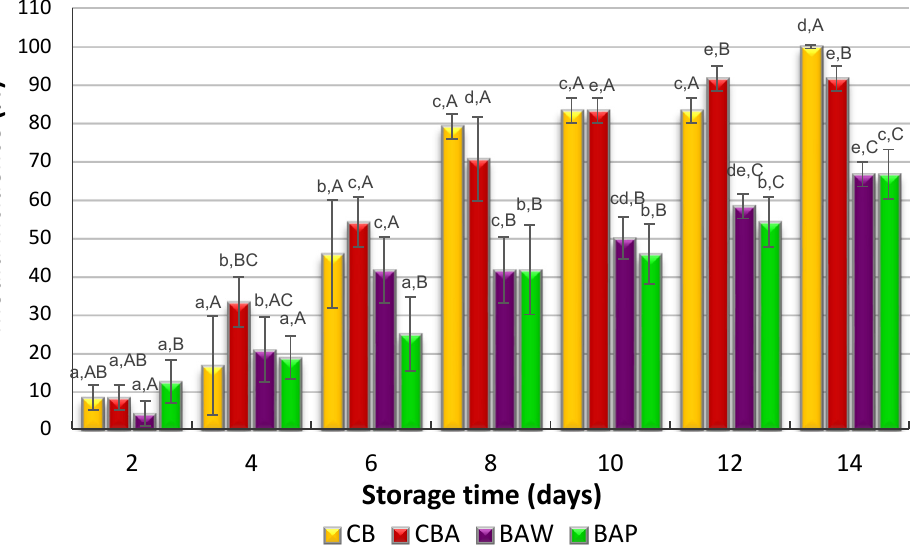
Figure 3. The effect of biofilms with W. anomalus or P. membranifaciens on the incidence of B. cinerea on apple fruit. CB: fruit injured and inoculated with B. cinerea ; CBA: fruit injured and inoculated with B. cinerea , coated with alginate; BAW: fruit injured and inoculated with B. cinerea , coated with alginate containing W. anomalus ; BAP: fruit injured and inoculated with B. cinerea , coated with alginate containing P. membranifaciens. a–e: values with different superscript Roman letters (for each storage time) were significantly different ( p < 0.05); A–C: values with different superscript Roman letters (for each treatment) were significantly different ( p <